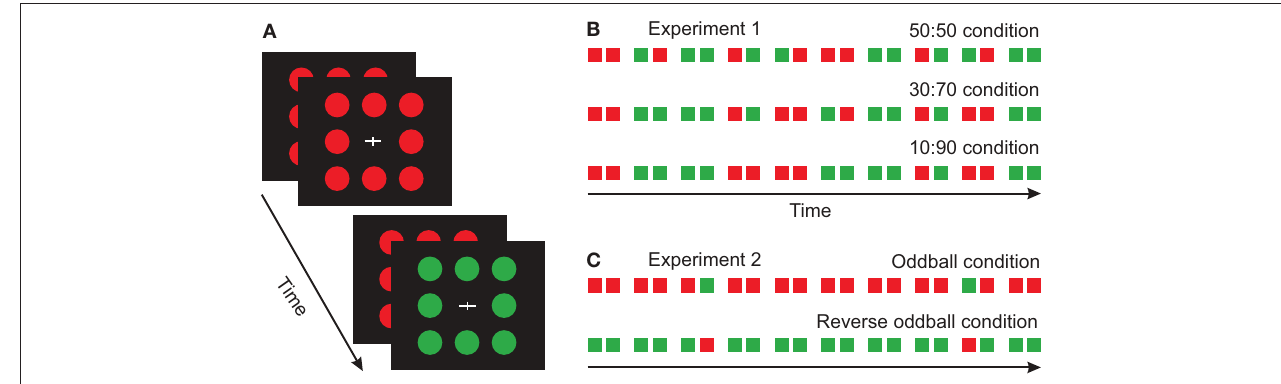
Figure 1 | Stimuli and paradigms. (A) Schematic illustration of the disk pattern stimuli used in the experiments. (B) The three different probability conditions applied in Experiment 1. (C) The oddball conditions in